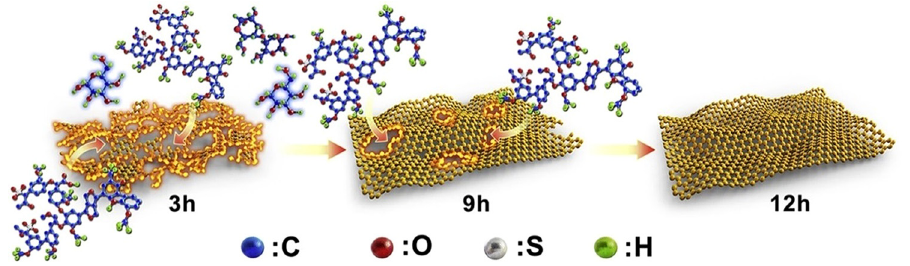
Figure 11: Three - dimensional graphene schematic. Copied with permission from ref. [ 116 ] ; Elsevier,